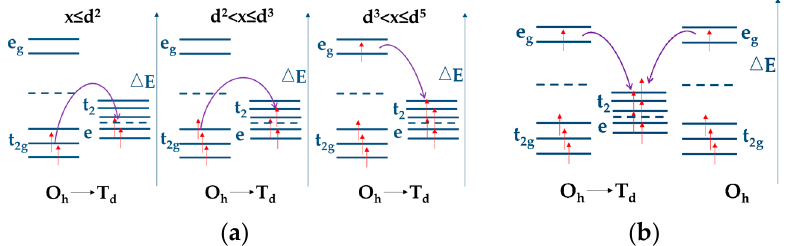
Figure 7. ( a ) The change of d electrons when TM ions move from O h to T d coordination. ( b ) Illustration of the charge disproportionation of Mn 3+ . (Adapted with permission from [2], Copyright 2004, American Chemical Society).